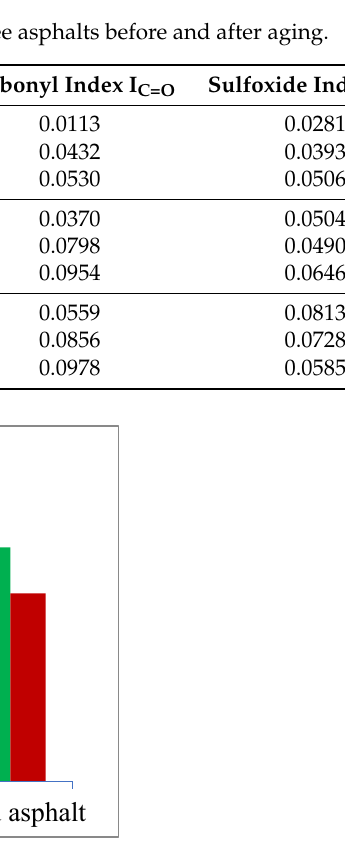
Figure 6. Carbonyl index of the three asphalts before and after aging. From Figures 5 and 6 and Table 4, it can be seen that after RTFOT aging and PAV aging, the sulfoxide group index of the matrix asphalt continues to increase. Thus, the sulfur element in the matrix asphalt is oxidized to the sulfoxide group in succession dur- ing aging. During the RTFOT aging and PAV aging process, the change law of the sulfox- ide group of recycled asphalt is just opposite to that of the matrix asphalt. This is because the sulfur element in recycled asphalt mainly exists in the form of sulfoxide group. During the aging process, some sulfoxide groups generate hydrogen sulfide, resulting in the de- crease of the sulfoxide group index. The sulfur element in the matrix asphalt mainly exists in the form of elemental or other chemical states, and is oxidized to the sulfoxide group, which leads to the increase of its sulfoxide group index. However, in the aging process of old and new asphalt, both the sulfoxide group of recycled asphalt decreases and the sul- foxide group of the matrix asphalt increases. Therefore, the sulfoxide group index is rela- tively constant in RTFOT aging, but it still shows an upward trend after PAV aging. Next, we compare and analyze the changes of carbonyl index after RTFOT aging and PAV aging. The relationship between carbonyl indexes in three original asphalts is recy- cled asphalt > new and old asphalt > matrix asphalt. After RTFOT aging, the carbonyl index of the three asphalts increases significantly, with an increase of 0.0297, 0.0428 and 0.0319, respectively. Obviously, the carbonyl index of new and old asphalt increases largely. The difference between the carbonyl indexes of recycled asphalt is greatly re- duced, and that of the matrix asphalt is increased. Therefore, compared with the matrix asphalt, the anti-aging ability of new and old asphalt declines rapidly in the short-term